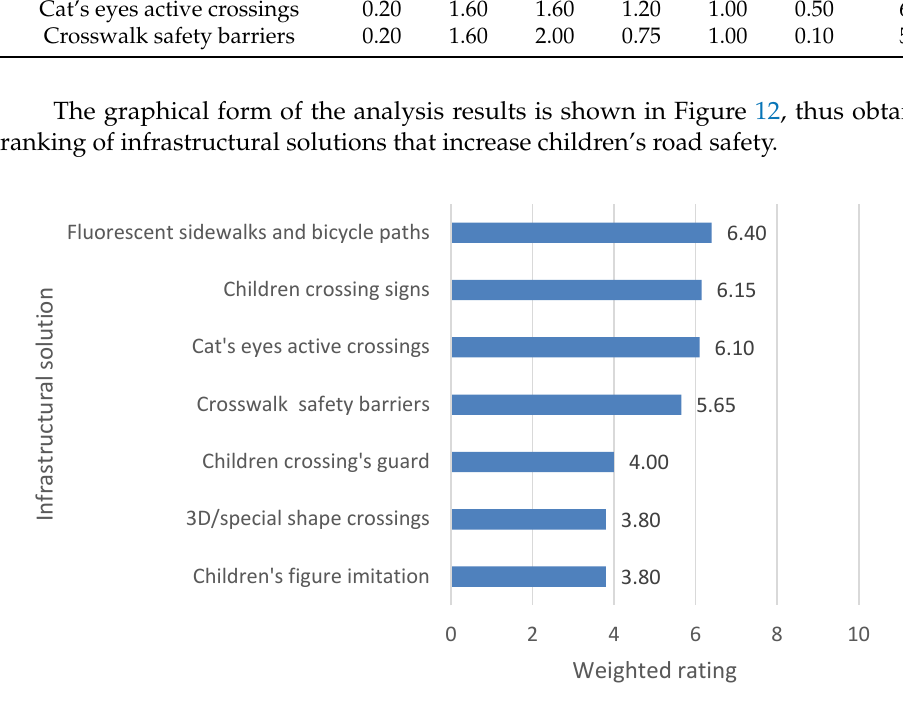
Figure 12. Ranking of infrastructural solutions increasing children ’ s road safety.